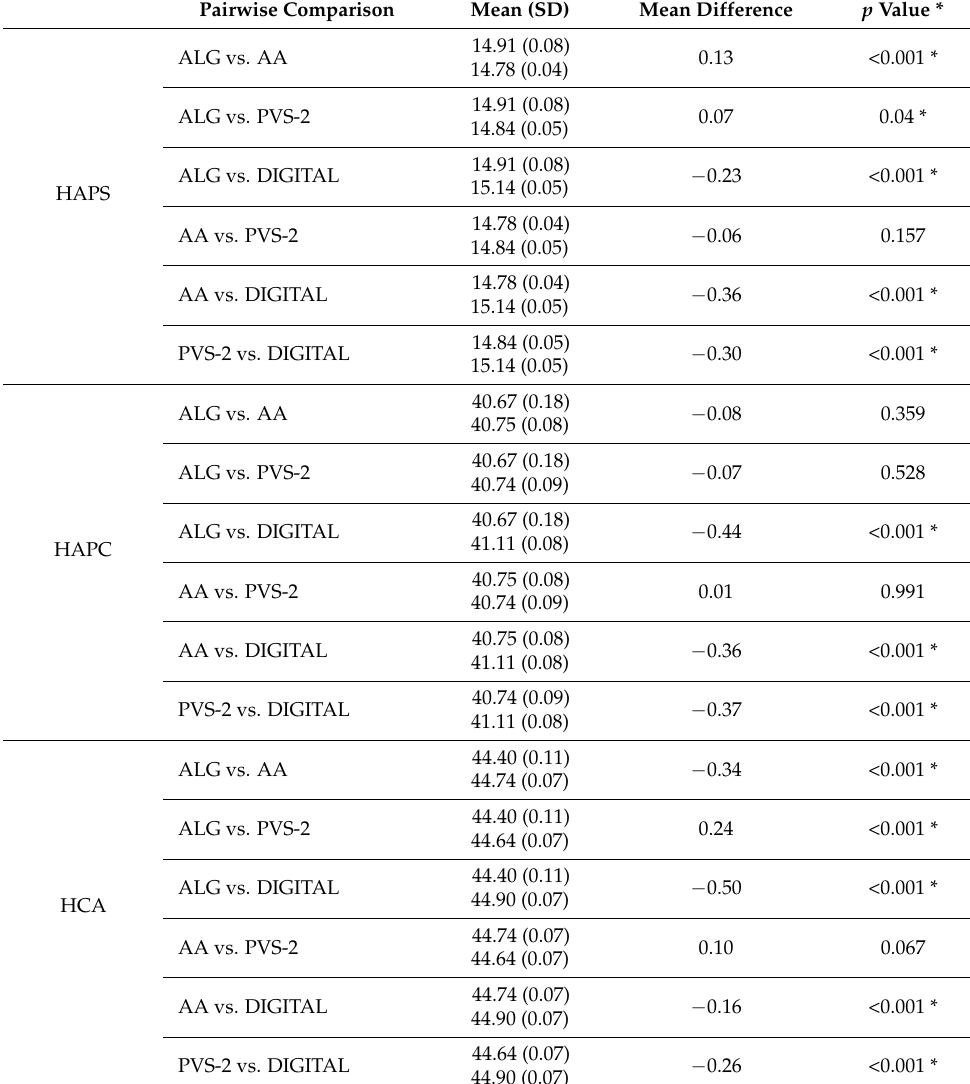
Table 4. Multiple pairwise comparisons of the accuracy of the three impression materials and digital impression using Tukey’s HSD